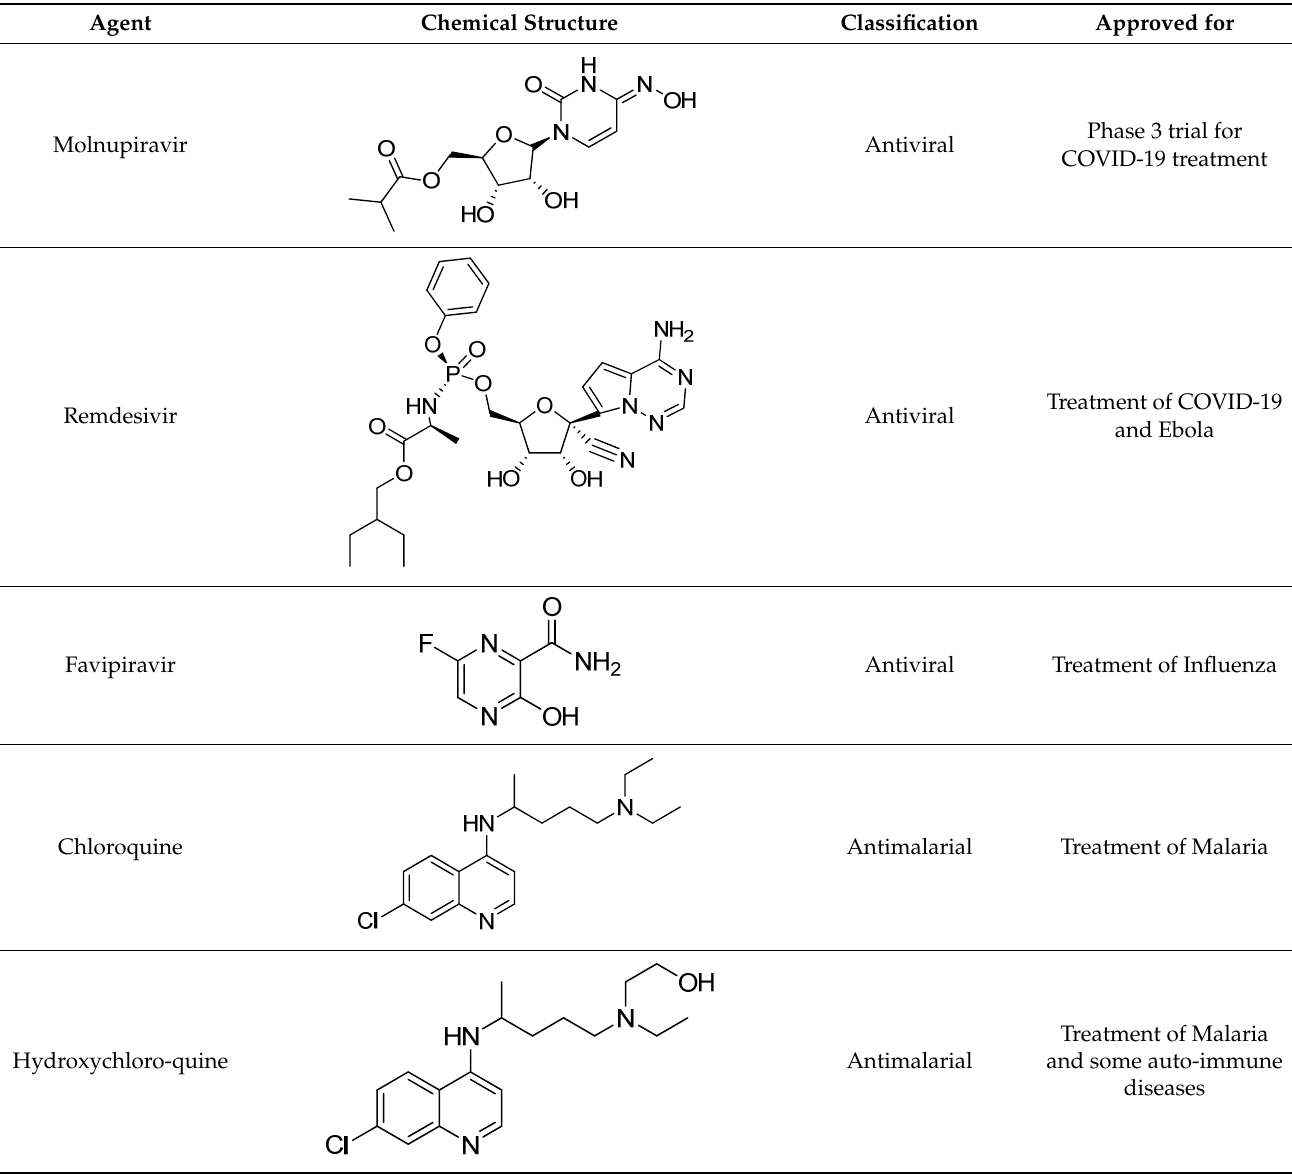
Table 1. A running list of repurposing drugs for COVID-19.